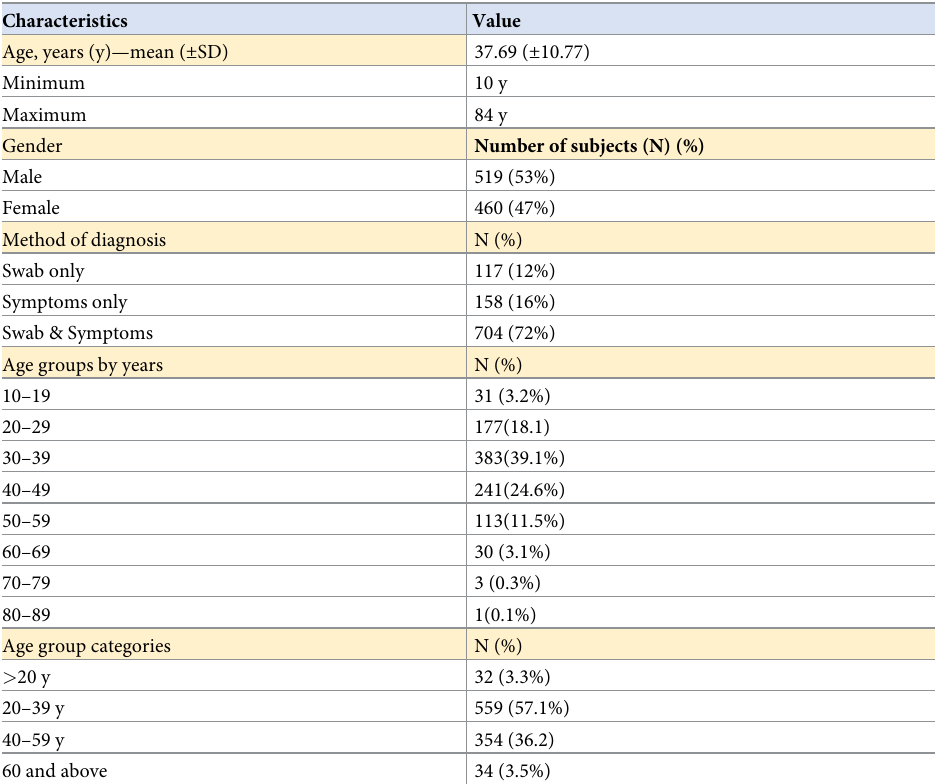
Table 1. Demographic and clinical characteristics of the study